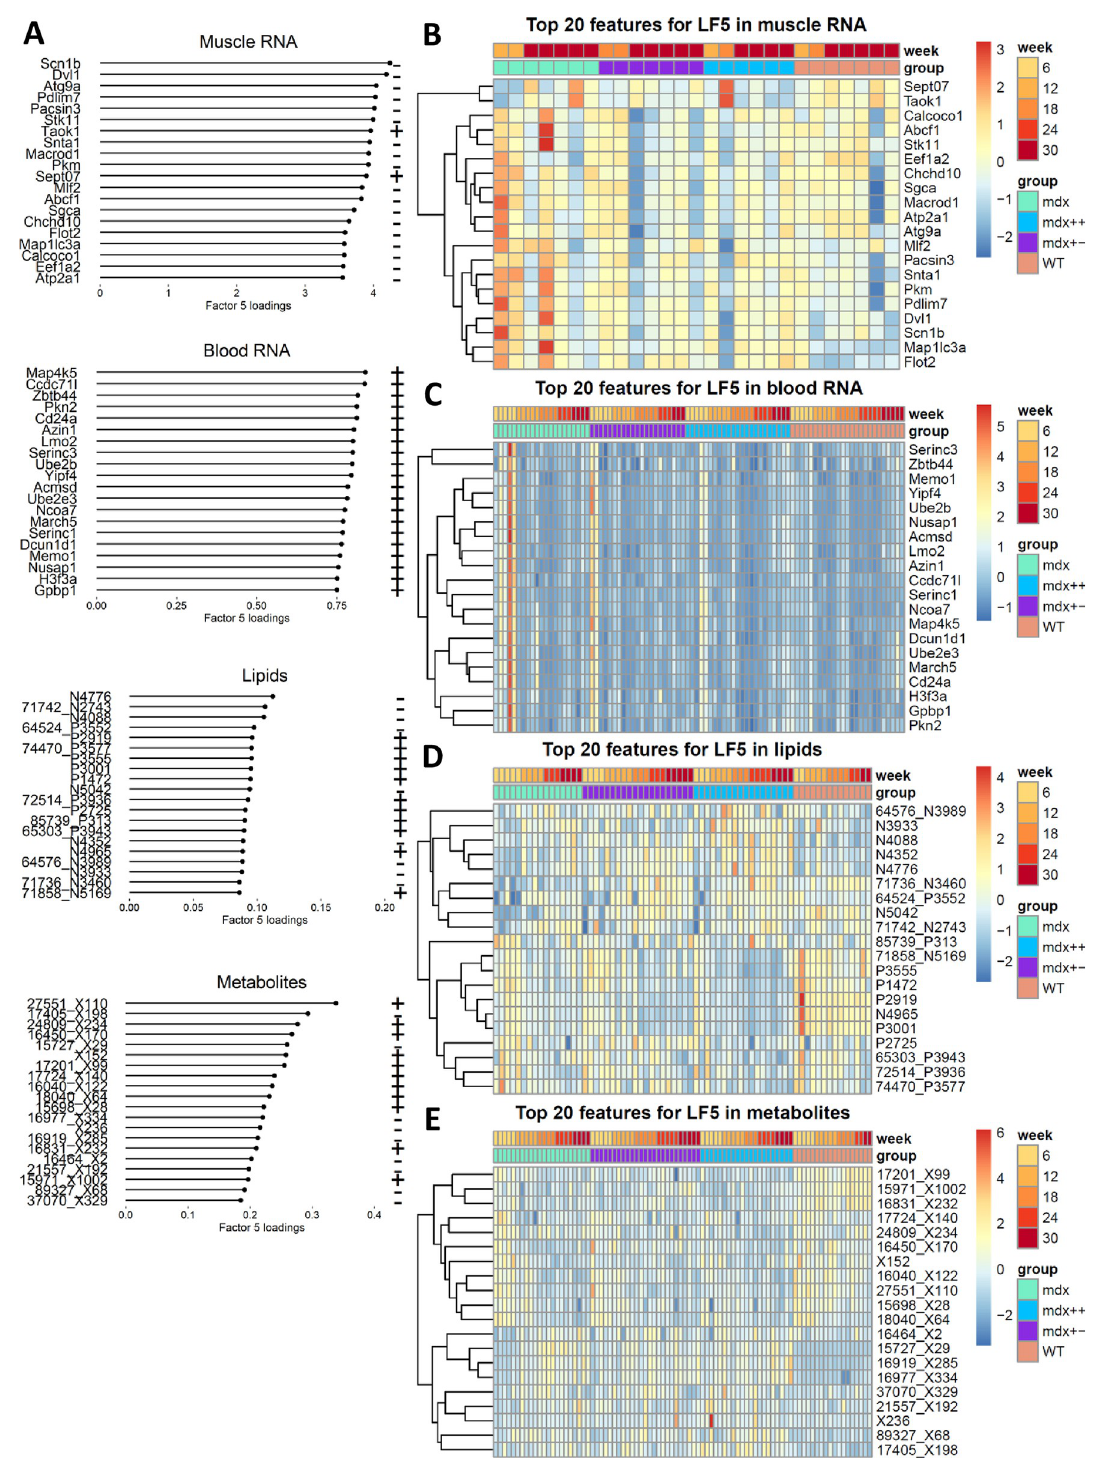
Fig 5. MOFA factor 3: Top 10 molecules by factor weight in each omic view. A) Factor 3 weights for the top 10 genes, lipids and metabolites by factor weight in muscle RNA, blood RNA, lipids and metabolites. B-E) Heatmaps showing the distribution of the top 10 molecules by factor weight in muscle RNA (panel B), blood RNA (panel C), lipids (panel D) and metabolites (panel E) across samples.